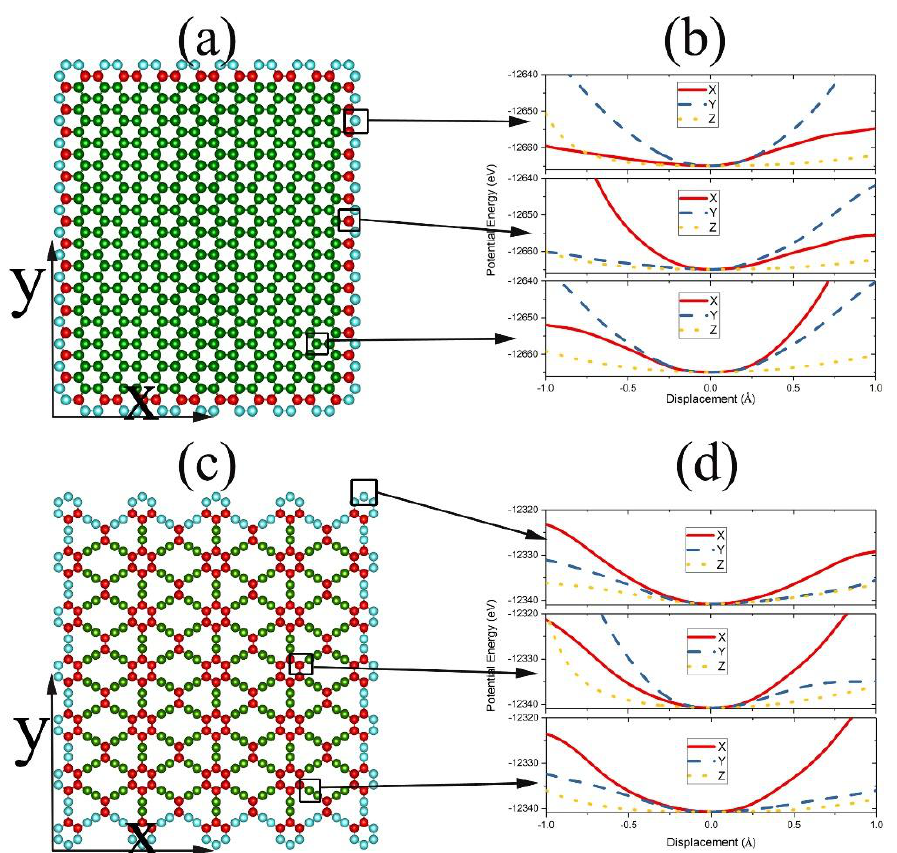
Figure 2. Top view of a graphene sheet ( a ) and a γ-graphyne sheet ( c ) on a Cu (111) substrate. The potential energy 𝑼 ′ ( b , d ) felt by a C atom moving along the X-, Y-, or Z-axis depends on the specific surrounding of the C atom.